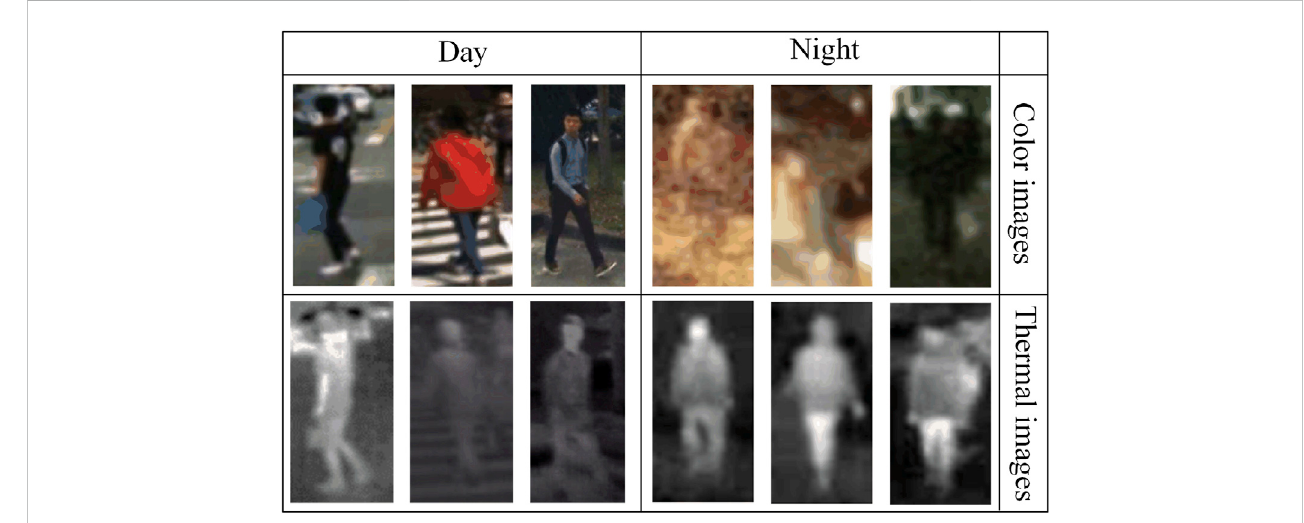
FIGURE 1 Example of color and thermal images of pedestrians in daytime and nighttime